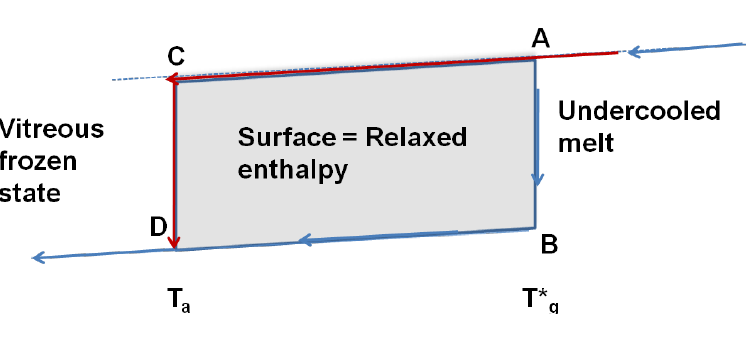
Figure 10. The reversible thermodynamic vitreous transition occurs at T = T* ; the g specific heat decreases along AB; the specific heat of the vitreous fully-frozen state along BD is equal to the crystallized state. The undercooled melt is quenched at low temperatures and annealed at the temperature T . The transformation from C to D relaxes an enthalpy a equal to the surface ABDC when the time-lag necessary for cluster formation has